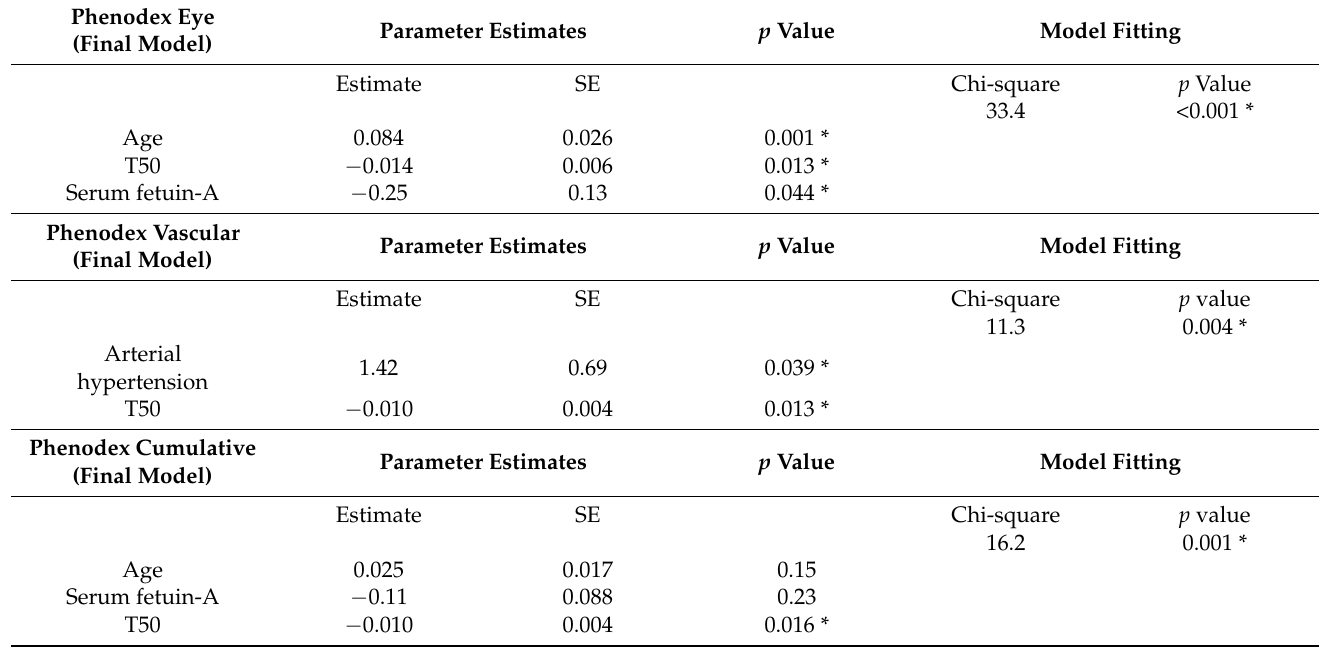
Table 3. Multivariate models of determinants of Phenodex Eye, Vascular and Cumulative scores in PXE. Serum T50 independently and inversely associated with ophthalmological, vascular and overall disease severity in PXE patients. SE—standard error. * p <